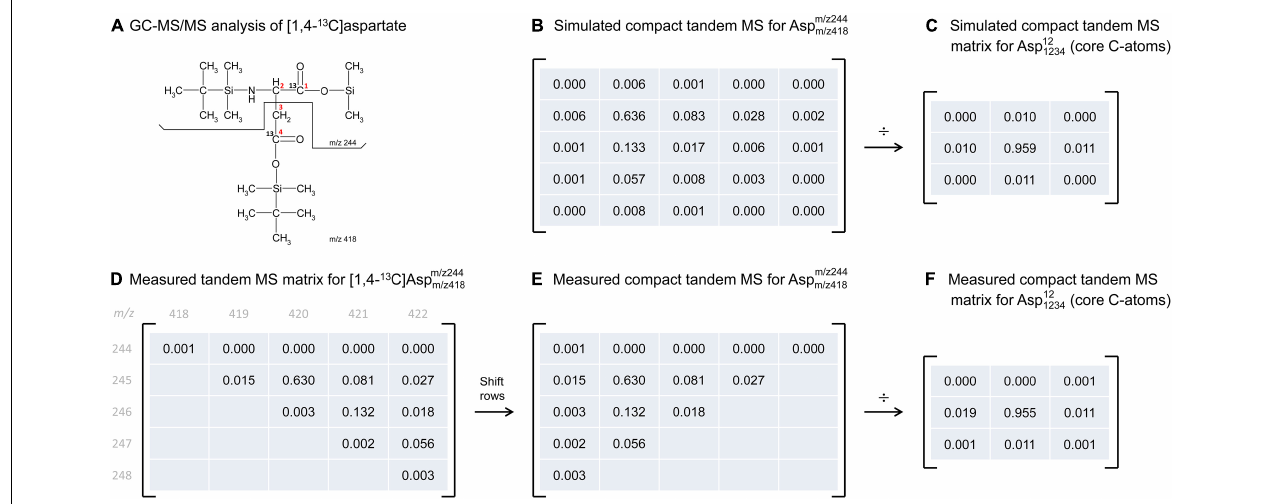
FIGURE 3 | Illustration of natural abundance correction for both simulated and measured tandem MS data. (A) GC-MS/MS analysis was performed on TBDMS-derivatized [1,4- 13 C]aspartate, where the parent fragment contains all four carbon atoms of aspartate, and the daughter fragment contains carbon atoms C1 and C2 of aspartate. (B) The predicted compact tandem MS matrix for [1,4- 13 C]aspartate m/z 418 > 244 parent-daughter pair (assuming 99% isotopic purity), and (C) the corresponding corrected compact tandem MS matrix reflecting the labeling of core C-atoms. Correction for natural isotope abundances was performed by 2D-deconvolution (denoted here by “ ÷ ”). (D) Measured tandem MS matrix for [1,4- 13 C]aspartate m/z 418 > 244 parent-daughter pair, as reported by Choi et al. (2012), and (E) the corresponding compact tandem MS matrix. (F) The corrected compact tandem MS matrix, i.e., reflecting the labeling of only the core C-atoms, was obtained after correction for natural isotope abundances using 2D-deconvolution (denoted here by “ ÷